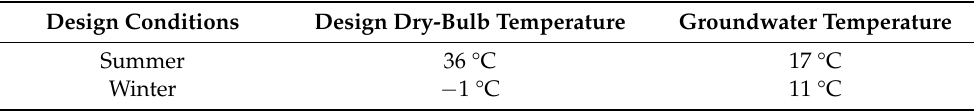
Table 5. Air conditioning outdoor design temperature and groundwater temperature Reproduced from [48,49].